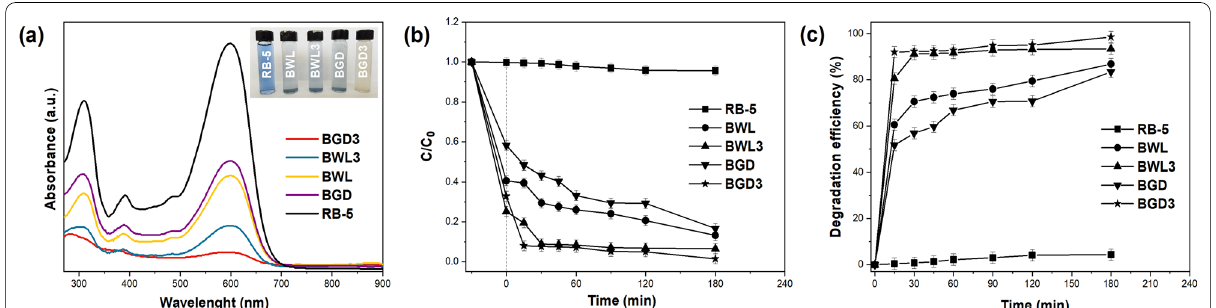
Fig. 5 UV–Vis absorption spectra, and inset of the vials at 15 min after starting RB‑5 degradation, photocatalytic degradation, and photocatalytic